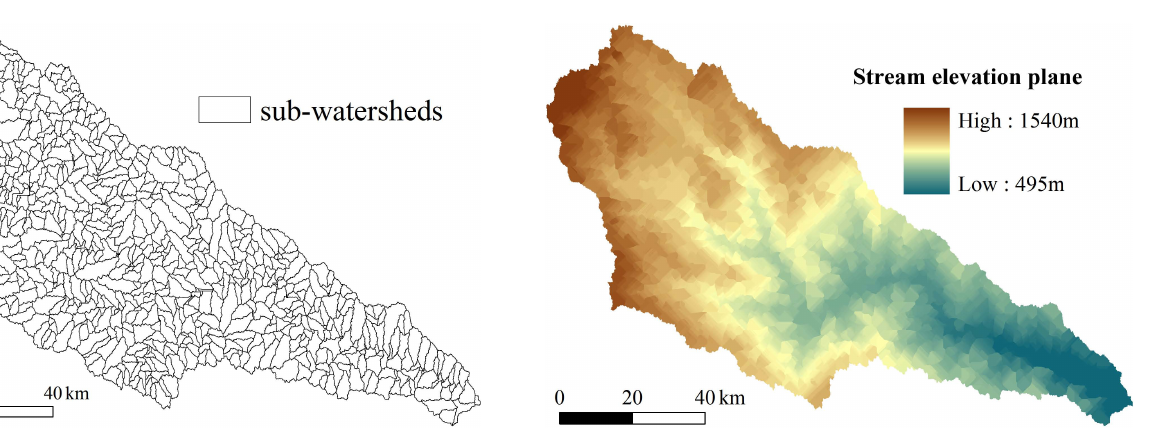
Fig. 3. Spatial distribution of the sub-watersheds in the Yanhe watershed.